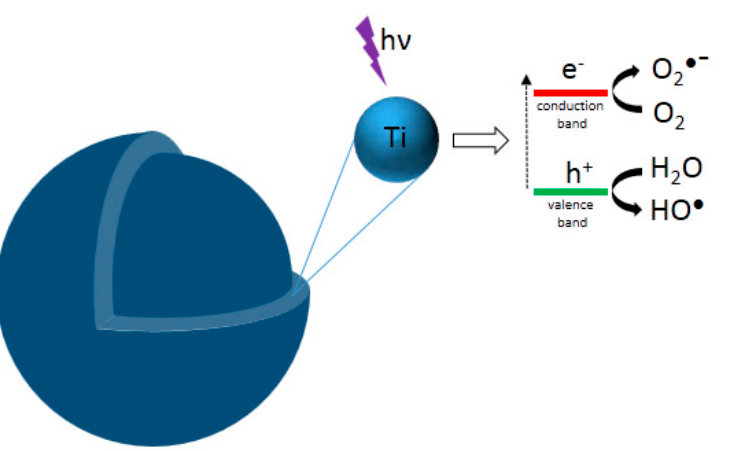
Figure 1. Schematic representation of photocatalytic TiO 2 NP: photogenerated charges (electron and hole) upon absorption of radiation.